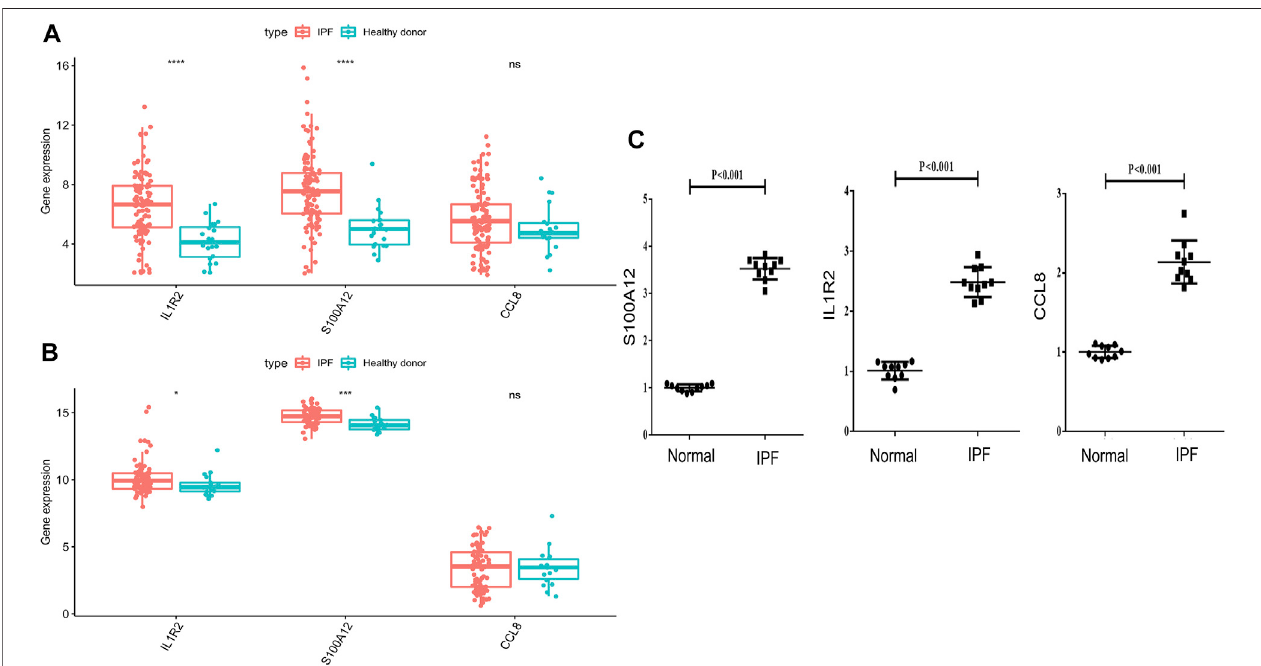
FIGURE 9 | Validation of mRNA expression levels of IL1R2, S100A12, and CCL8 with the GSE708066 and GSE28221 datasets and qRT-PCR. (A) Differences of three genes in GSE70867-GPL14550. (B) Differences of three genes in GSE28221-GPL6480. (C) mRNA expression levels of IL1R2, S100A12, and CCL8 tested by